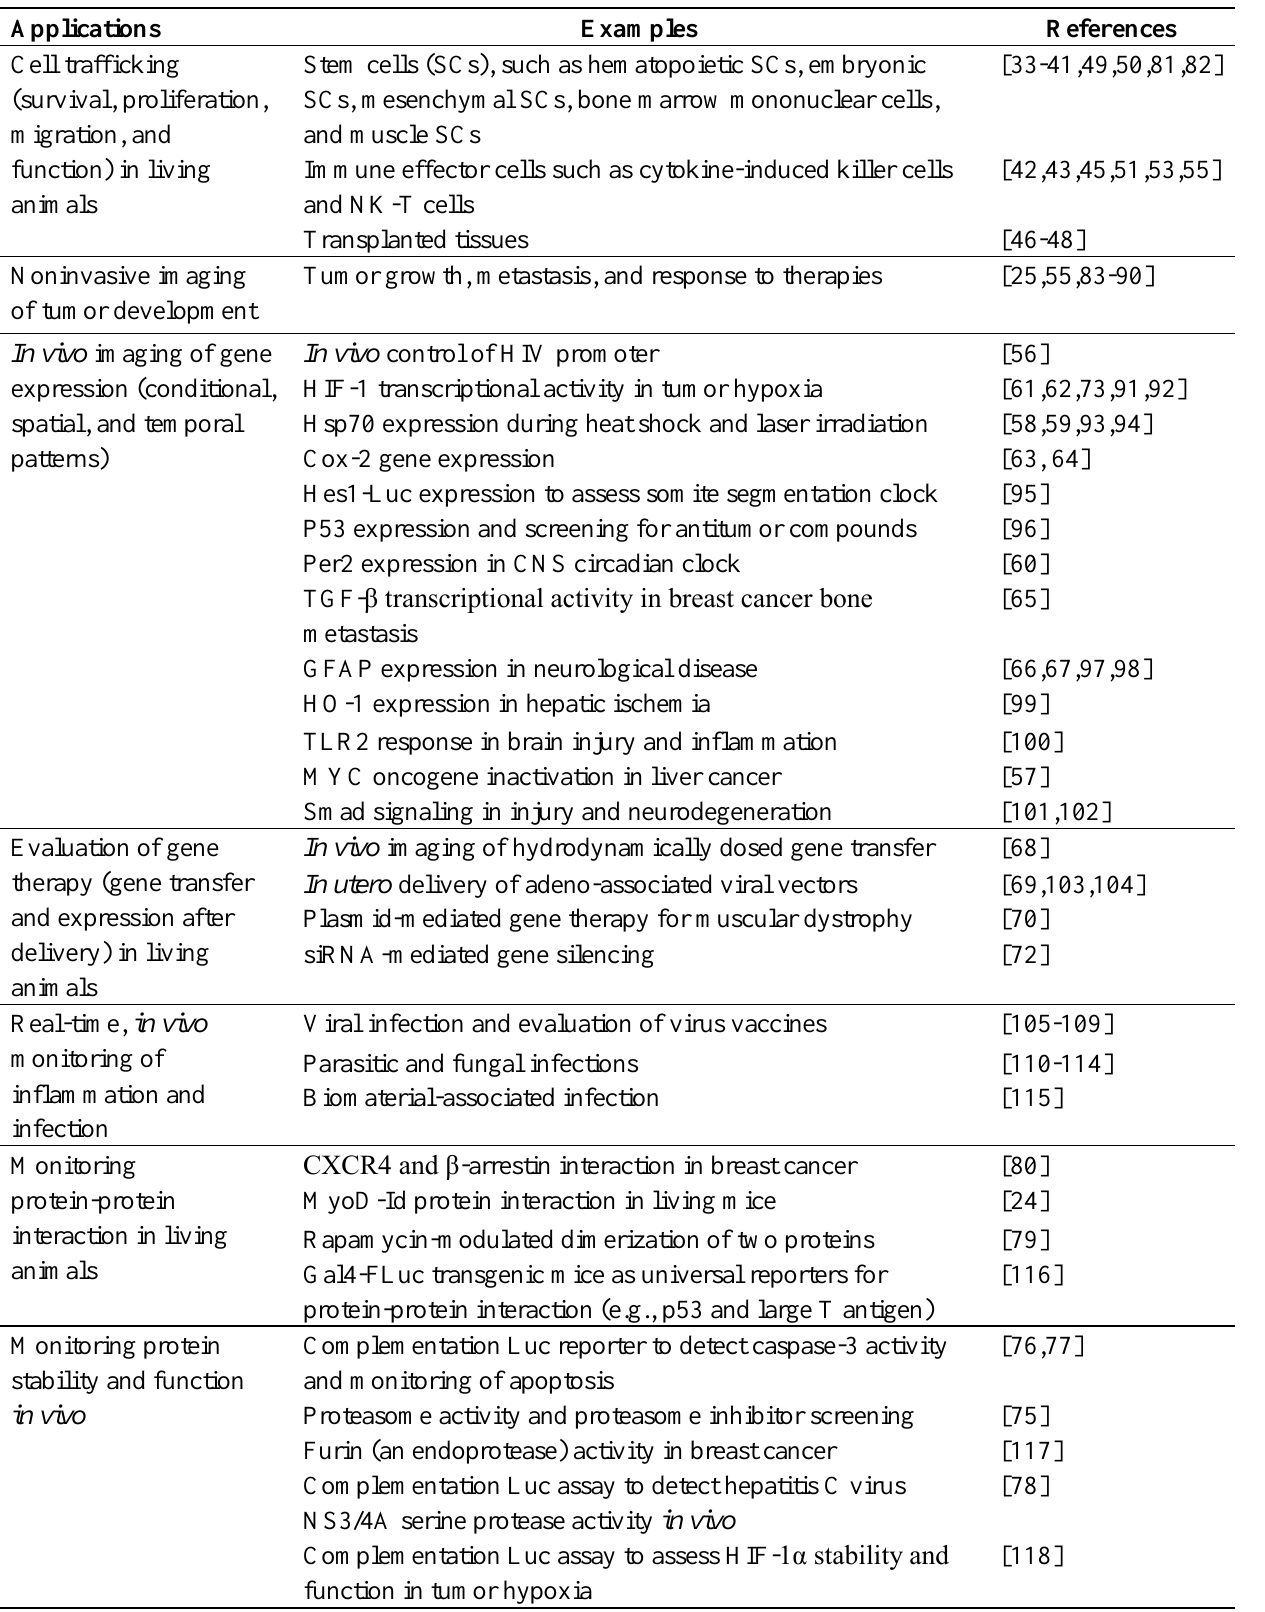
Table 3. Selected BLI applications of firefly and Renilla luciferases (FLuc and RLuc).